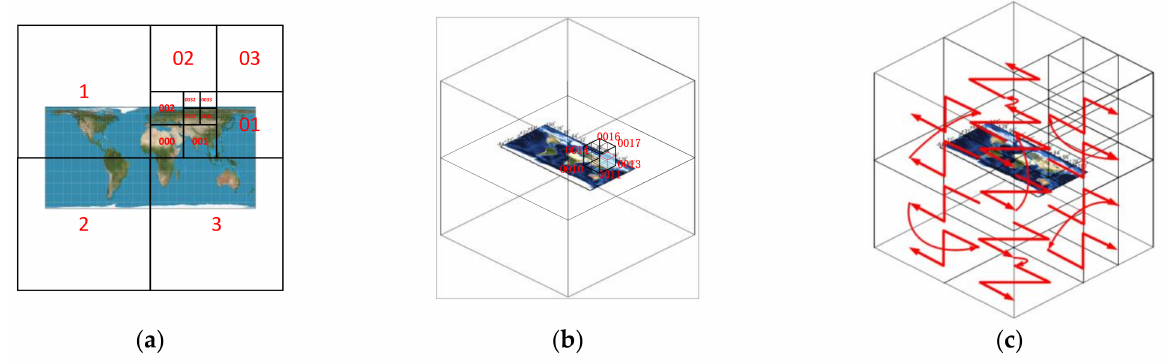
Figure 2. GeoSOT-3D model: ( a ) GeoSOT subdivision; ( b ) GeoSOT-3D subdivision; ( c ) Z-order filling